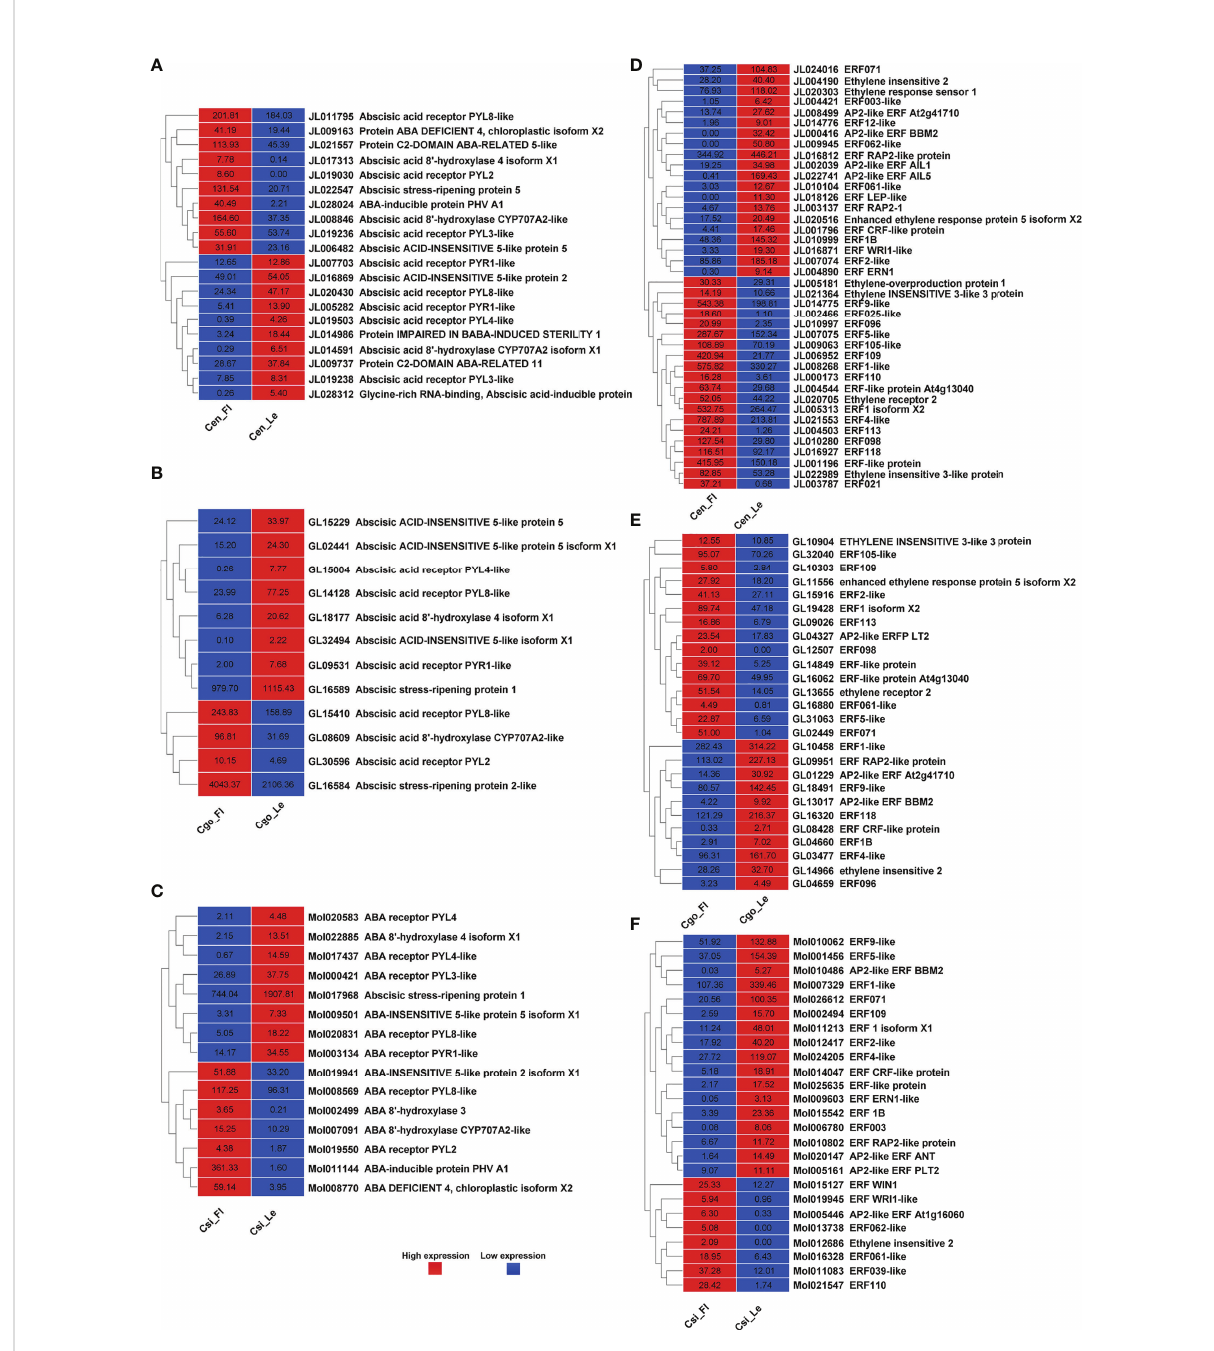
FIGURE 4 ABA pathway genes for C. ensifolium (A) , C. goeringii (B) and C. sinense (C) ; and ethylene pathway genes for C. ensifolium (D) , C. goeringii (E) and C. sinense (F)